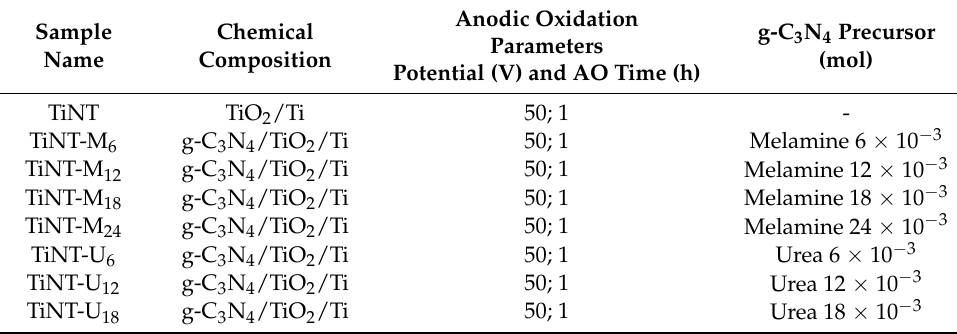
Table 1. Investigated samples and their characteristics of preparation [38].